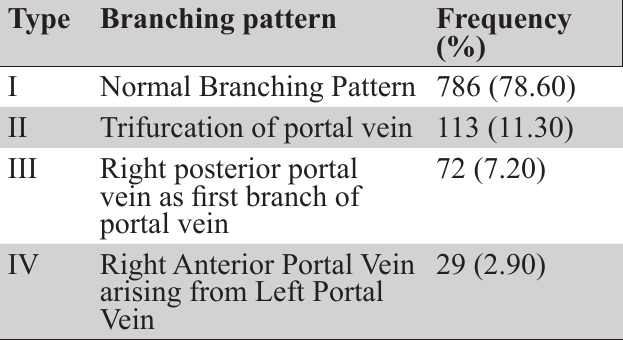
Fig 2. Axial CT scan showing trifurcation of portal vein. Fig 3. Axial CT scan showing RPPV as first branch Table 1. Various branching patterns of the portal vein (N=1000).